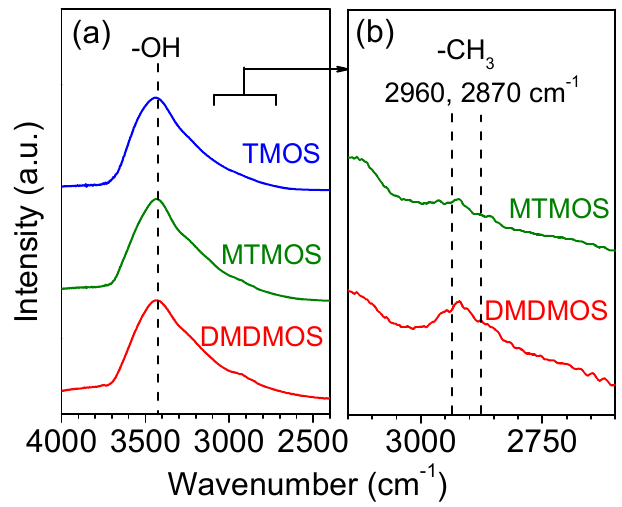
Figure 8. ( a ) Fourier-transform infrared (FTIR) spectra of the TMOS-, MTMOS-, and DMDMOS-derived membranes, and ( b ) the spectra of MTMOS- and DMDMOS-derived membranes after subtracting the spectra of the TMOS-derived membrane.